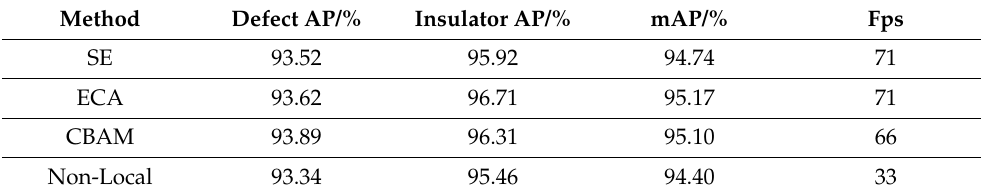
Table 3. Detection AP of the models with different attention mechanisms at